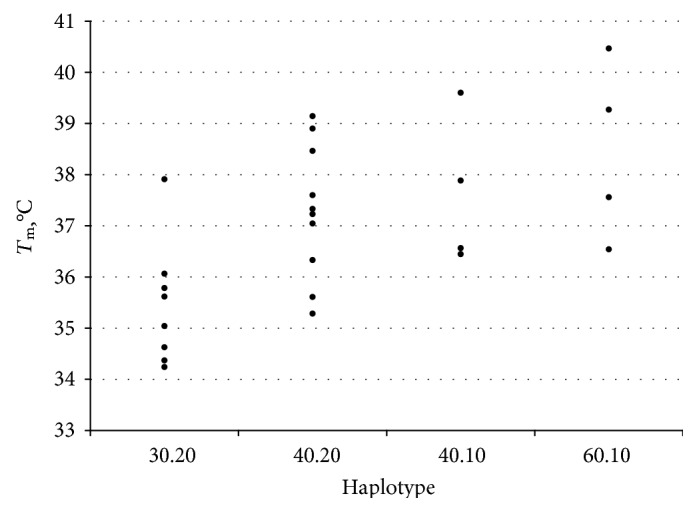
Dot plots of Tm values in Wagyu 300 ± 20 DOF in animals homozygous for the 5.24 Mb region MPRIP-TCAP. Wagyu cattle bred on different Australian farms (Goorambat, Irongate Wagyu, Mayura, Rosevale, and Peppermint Grove) were fed for 300 days at Mayura Station, South Australia, and beef/fat samples were assayed for C19 haplotypes and fat melting point Tm as indicated in Materials and Methods. Each dot point represents a different homozygote. Homozygous haplotypes for MPRIP-TCAP region only. Student's t-test for 30.20 versus 40.20 yields P = 0.012.